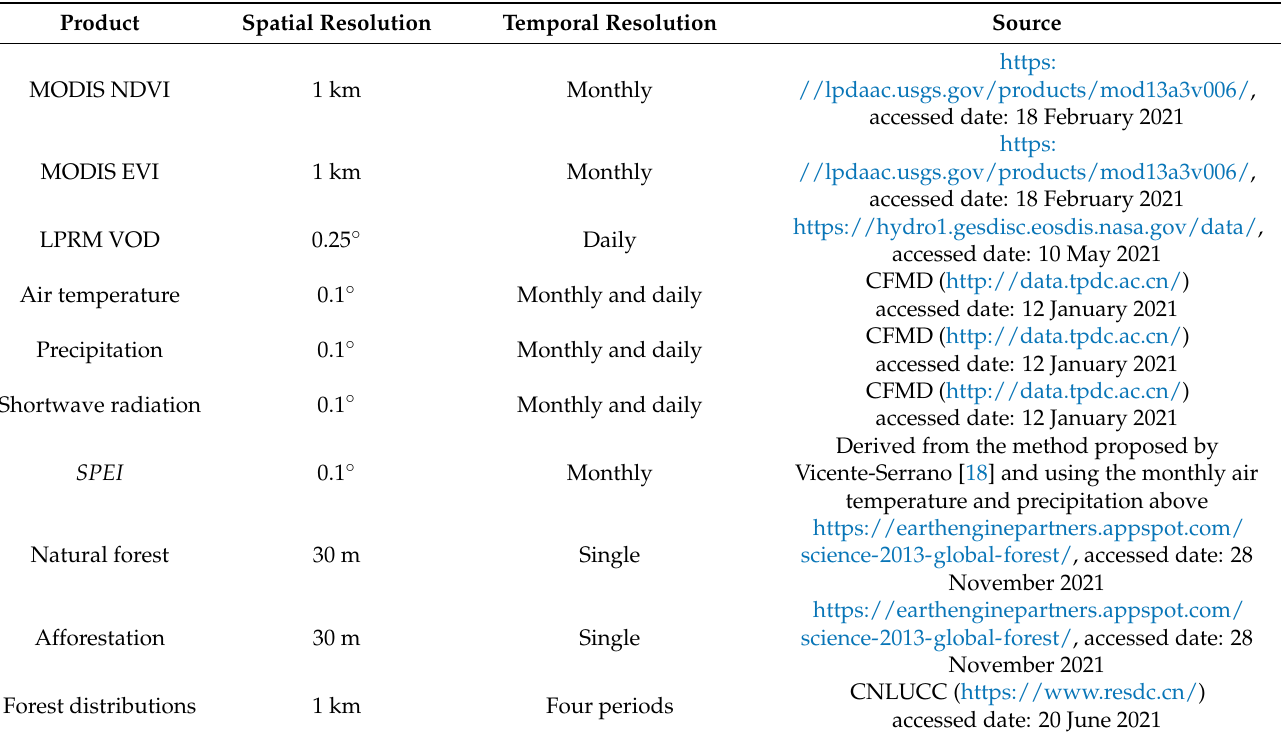
Table 1. Spatial and temporal resolutions, and sources of